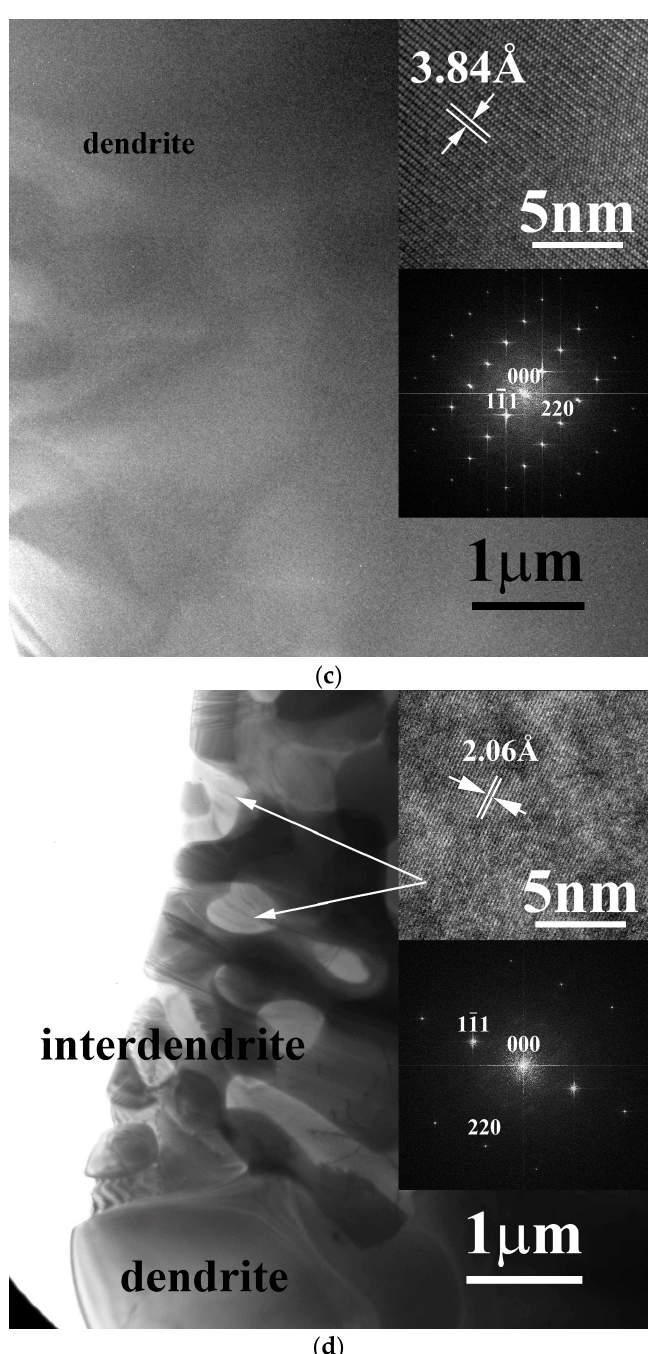
Figure 3. TEM images of the phases in FeCoNiNb 0.5 Mo 0.5 and FeCoNiNb alloys, and the corresponding lattice images and FFT diffraction patterns, ( a ) the dendrite of FeCoNiNb 0.5 Mo 0.5 alloy; ( b ) the laves phase in the interdendrite of FeCoNiNb 0.5 Mo 0.5 alloy; ( c ) the dendrite (FCC1 phase) of FeCoNiNb alloy; and ( d ) the FCC2 phase in the interdendrite of FeCoNiNb alloy.